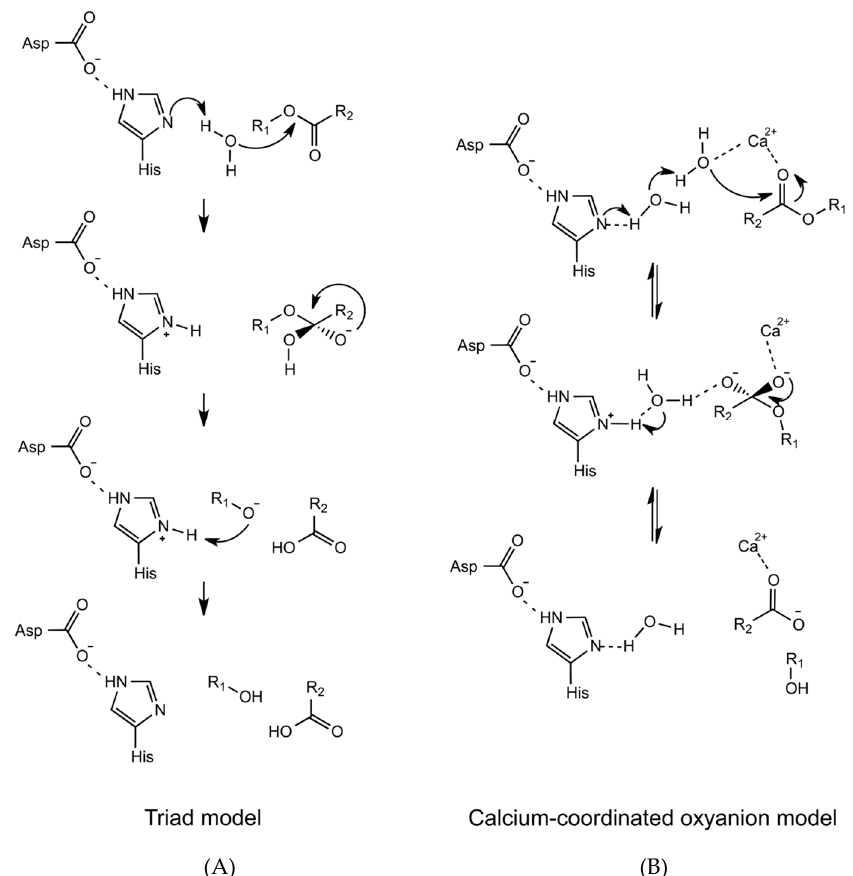
Figure 3. Two models of catalytic mechanism of hGIIA are depicted: ( A ) In the triad model, the water molecule becomes activated by the adjacent histidine N δ 1 atom, and acts as a nucleophile to directly attack the carbonyl of the substrate; ( B ) In the calcium-coordinated oxyanion model, a second water molecule is linked to the N δ 1 atom through the adjacent water molecule and also coordinated to the calcium ion. The water molecule and the calcium ion polarise the carbonyl group to initiate the cleavage, and the activation energy required is lower than the triad model. Adapted from Berg et al. [18].